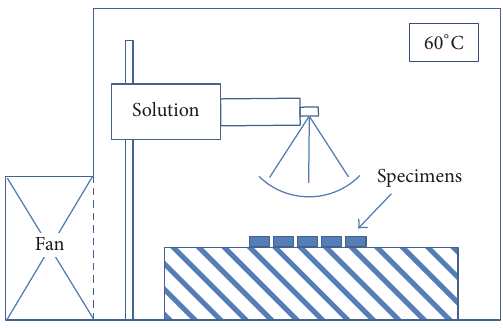
Figure 1: Illustration of coating preparation